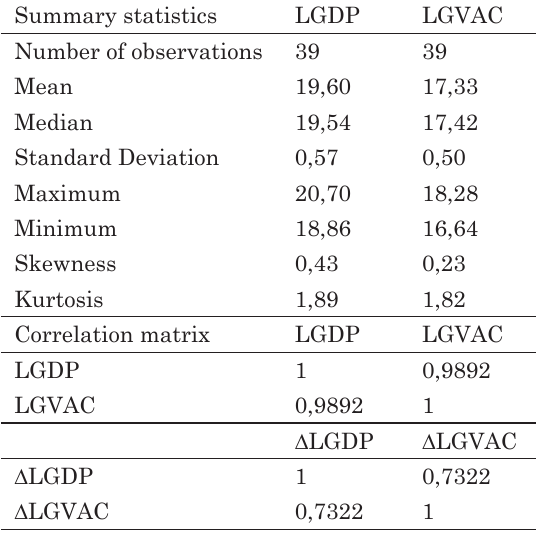
table 1. Summary statistics and correlation